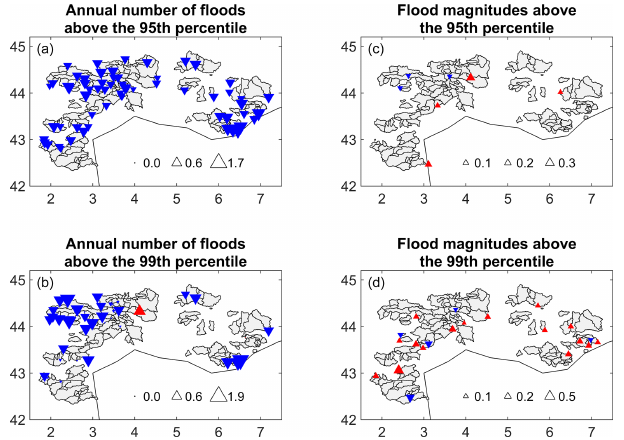
Figure 4. Significant trends at the 10% level (Mann–Kendall test) in the annual number of flood events above the 95th and 99th percentiles (a, b) and in the magnitude of these threshold ex- ceedances (c, d) . Blue triangles indicate a decrease and red triangles an increase. The size of the triangles indicates the relative changes.